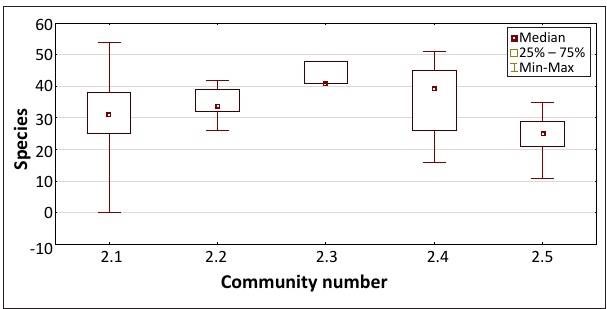
FIGURE 4: Species abundance of the communities within major community